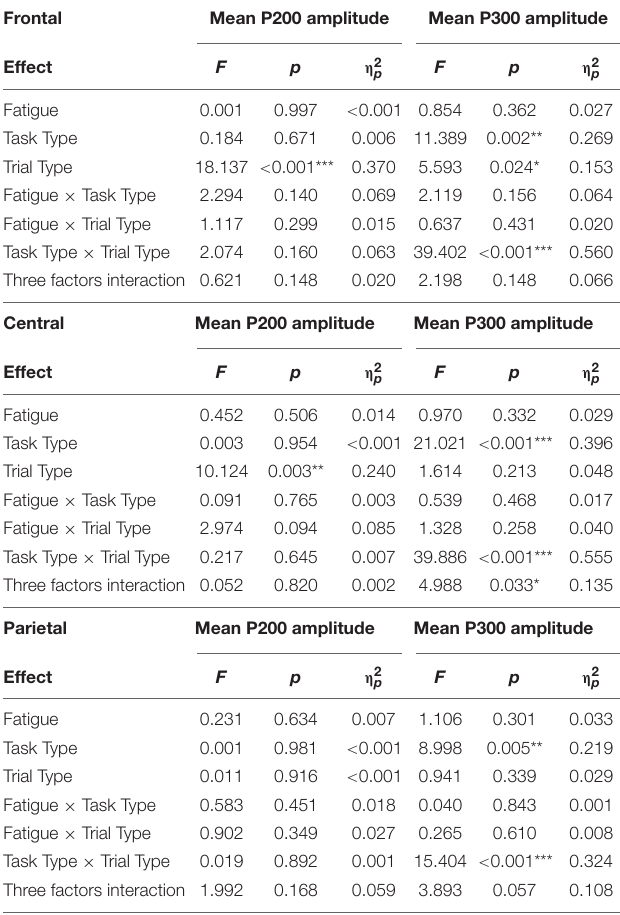
TABLE 3 | Three-way rm-ANOVA analyses results for P200 and P300 amplitudes at frontal, central, and parietal electrodes. Frontal Mean P200 amplitude Mean P300 amplitude